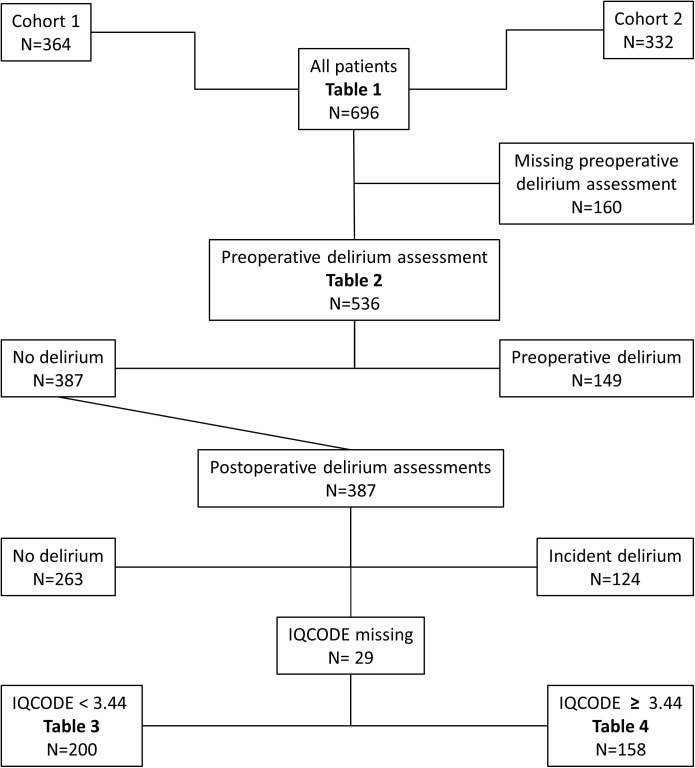
Study flowchart.Delirium assessments.